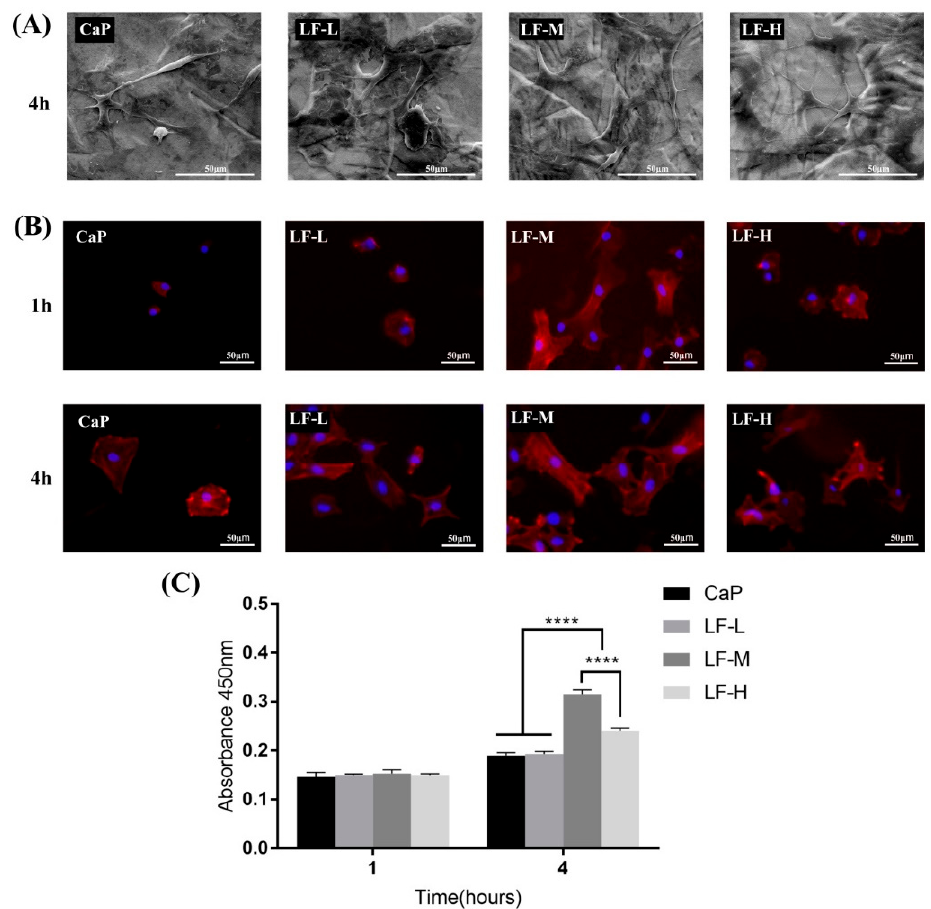
Figure 7. ( A ) SEM images of bone marrow stromal cells (BMSCs) cultured on CaP, LF-L, LF-M, and LF-H samples; ( B ) fluorescence microscopy images of BMSCs cultured on CaP, LF-L, LF-M, and LF-H samples for 1 and 4 h; F-actin was stained with rhodamine (red) and the nucleus with DAPI (blue); ( C ) quantitative cell early adhesion of BMSCs on CaP, LF-L, LF-M, and LF-H samples. **** p < 0.0001.